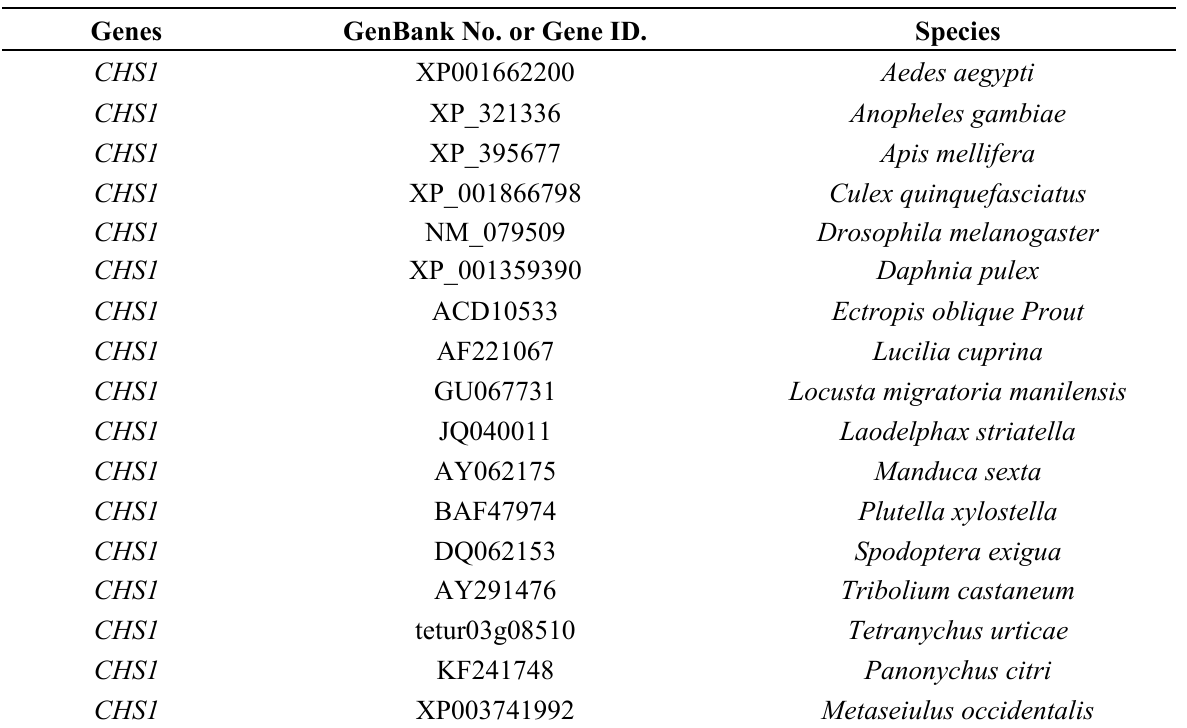
Table 1. Sequences and relevant information used for phylogenetic analysis of the chitin synthase 1 gene,